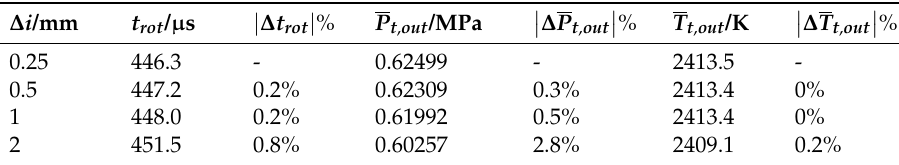
Table 1. Grid size independence validation (time step of 0.2 µ s).